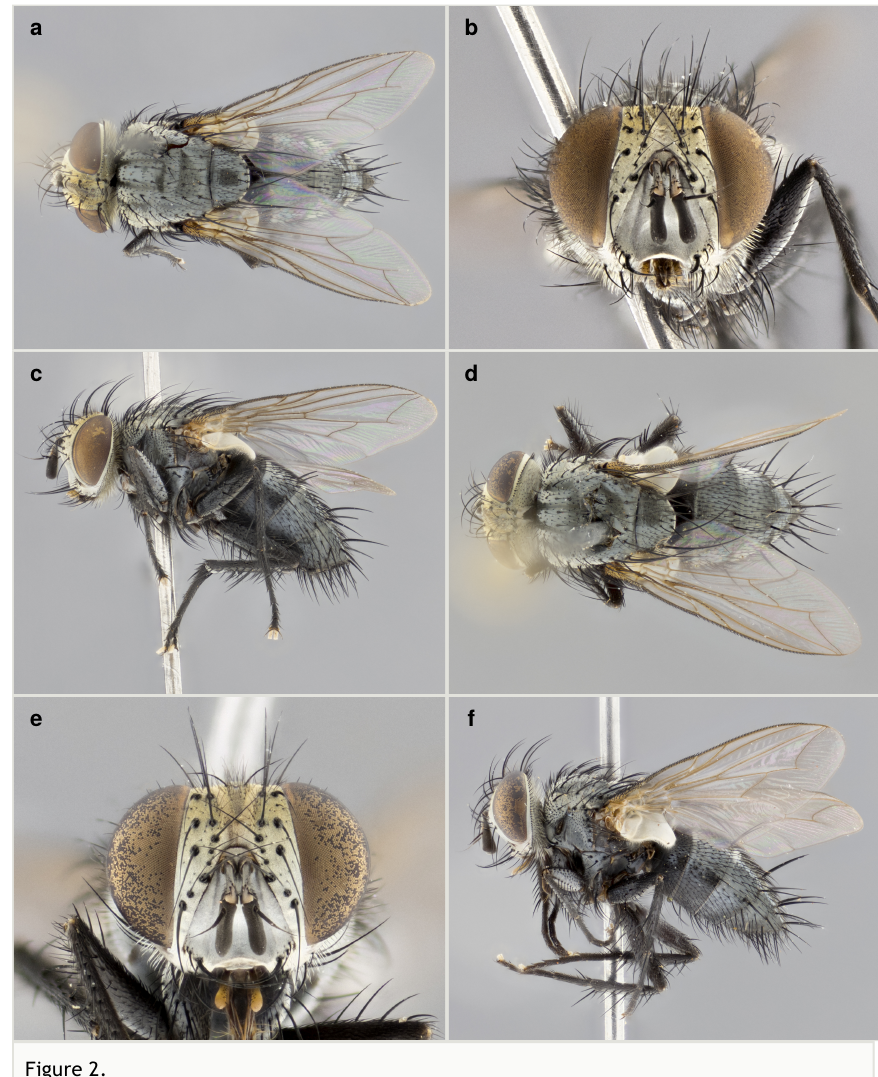
Figure 2. Voria erasmocoronadoi sp. n. a–c : holotype male, voucher n. DHJPAR0059183; d–f :